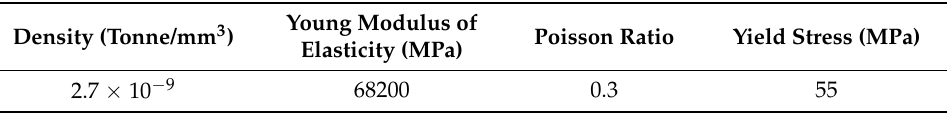
Table 3. Material properties of aluminium used as input parameters for numerical modeling of open-cell aluminium foam